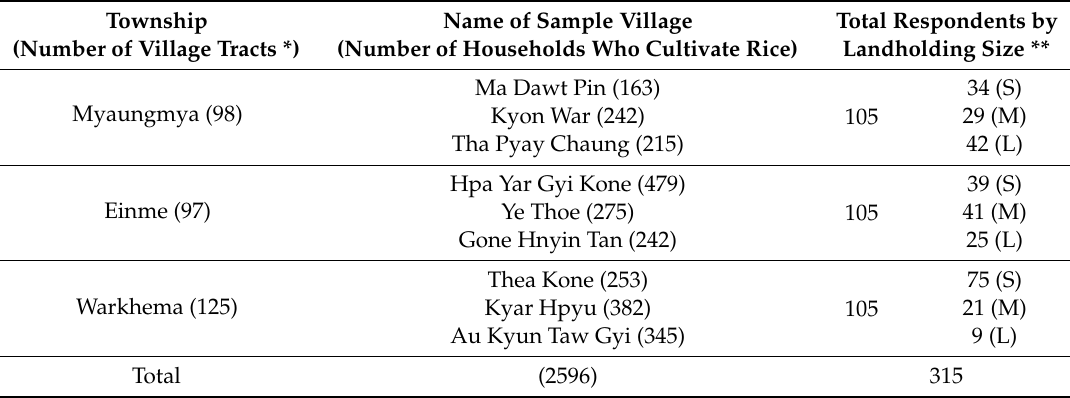
Figure 1. Location of the study area. Source: Author. Table 1. List of sample villages and the number of respondents.